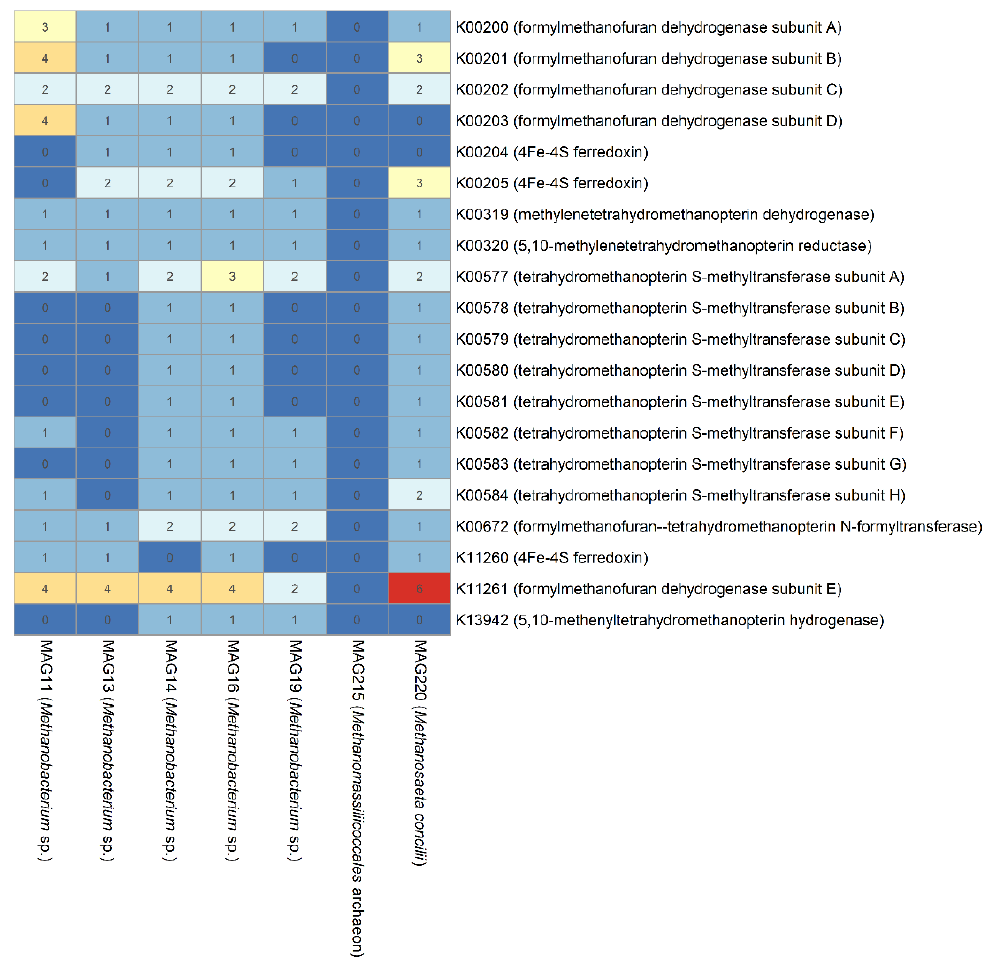
Figure 5. Numbers of genes involved in the relevant hydrogenotrophic methanogenesis pathway in archaeal